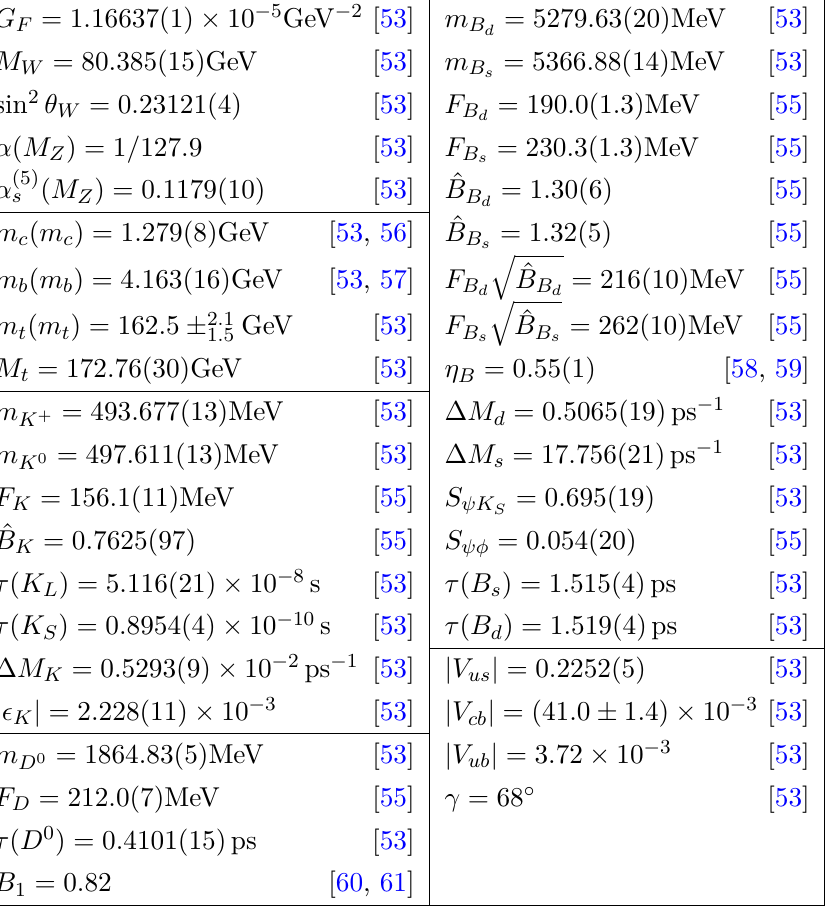
Table 1 . Values of the experimental and theoretical quantities used as input parameters or as experimental constraints for the observables analyzed in the 331